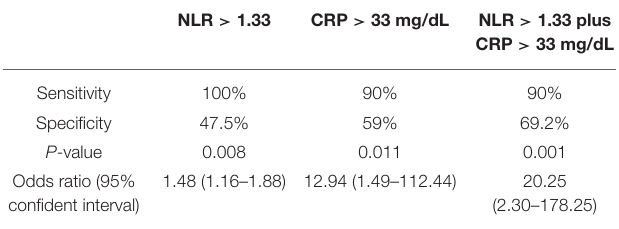
TABLE 3 | The sensitivity, specificity and odds ratio of